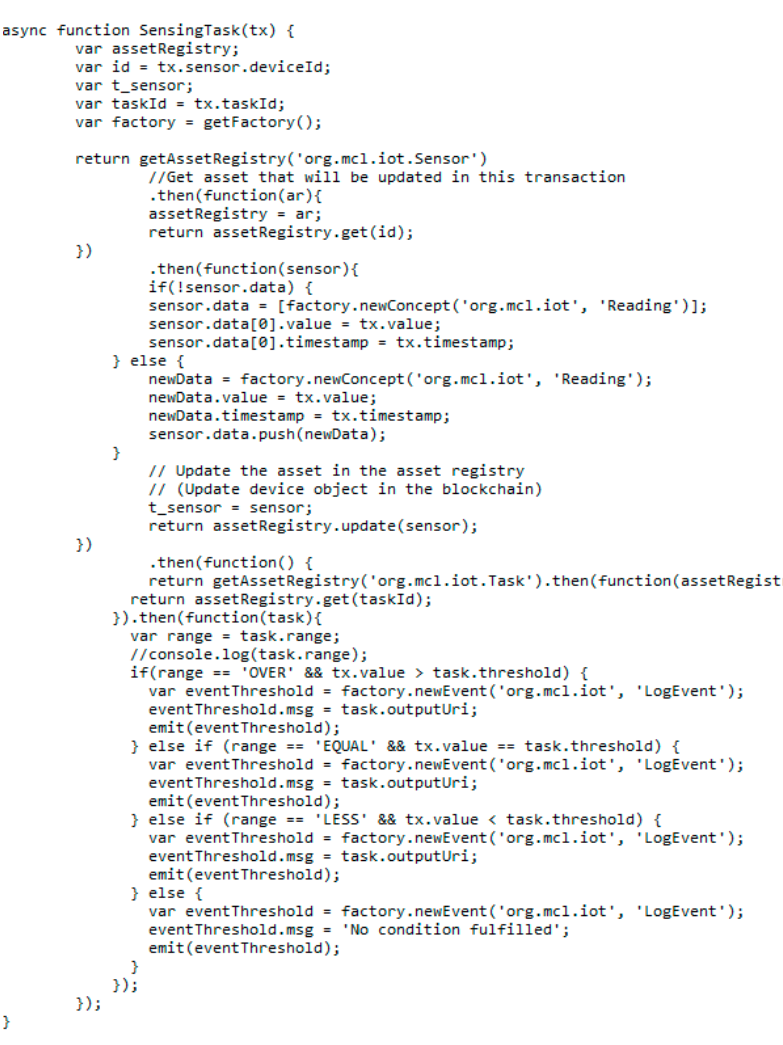
Figure 7. SensingTask transaction processor function.